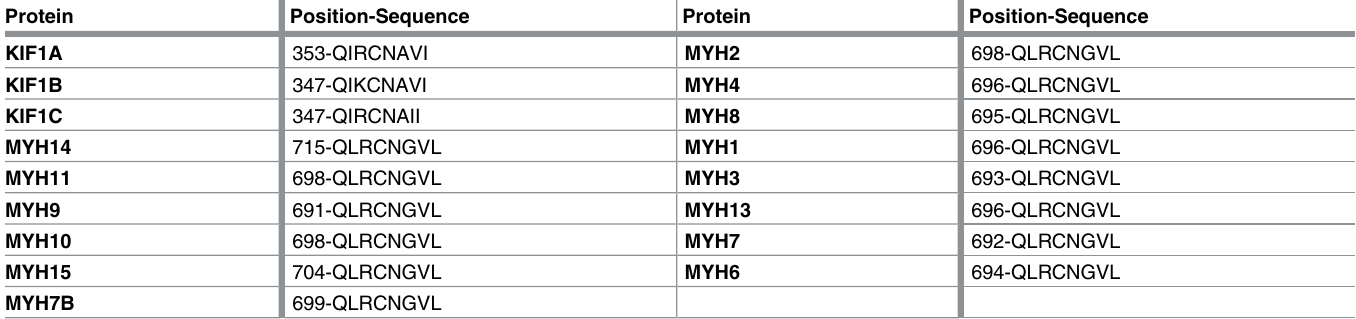
Table 17. Common motifs Myosin II and KIF 1A class of Kinesin, their position and sequences. Protein